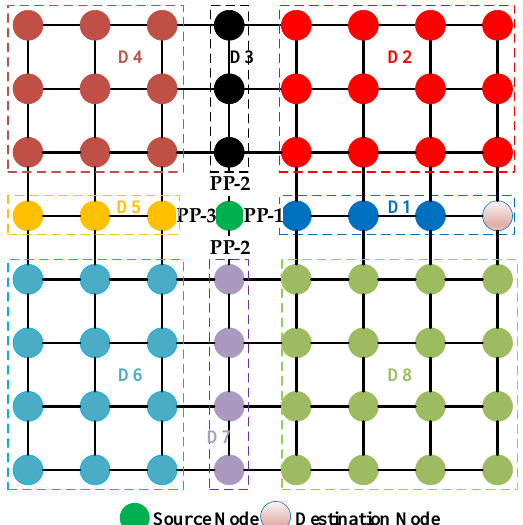
Figure 4. Network adaptive fault-tolerant routing (NAFTR) region distribution.